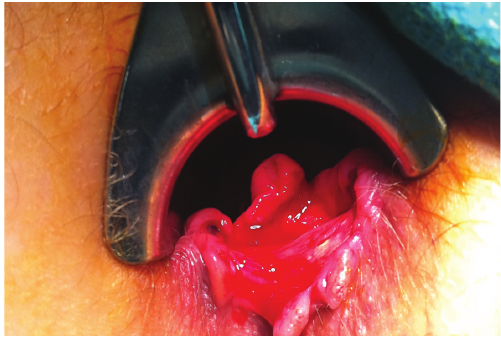
Figure 1: Large ano-rectal ulcer on exam under anesthesia.